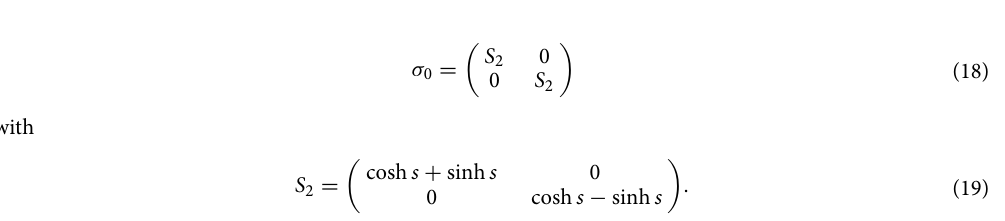
Figure 4. Lin-lin plot of quantum discord against time (in units of ω − s j state for different values of the squeezing parameter s . We set η | � of the plot. Discord D was calculated using Eq.